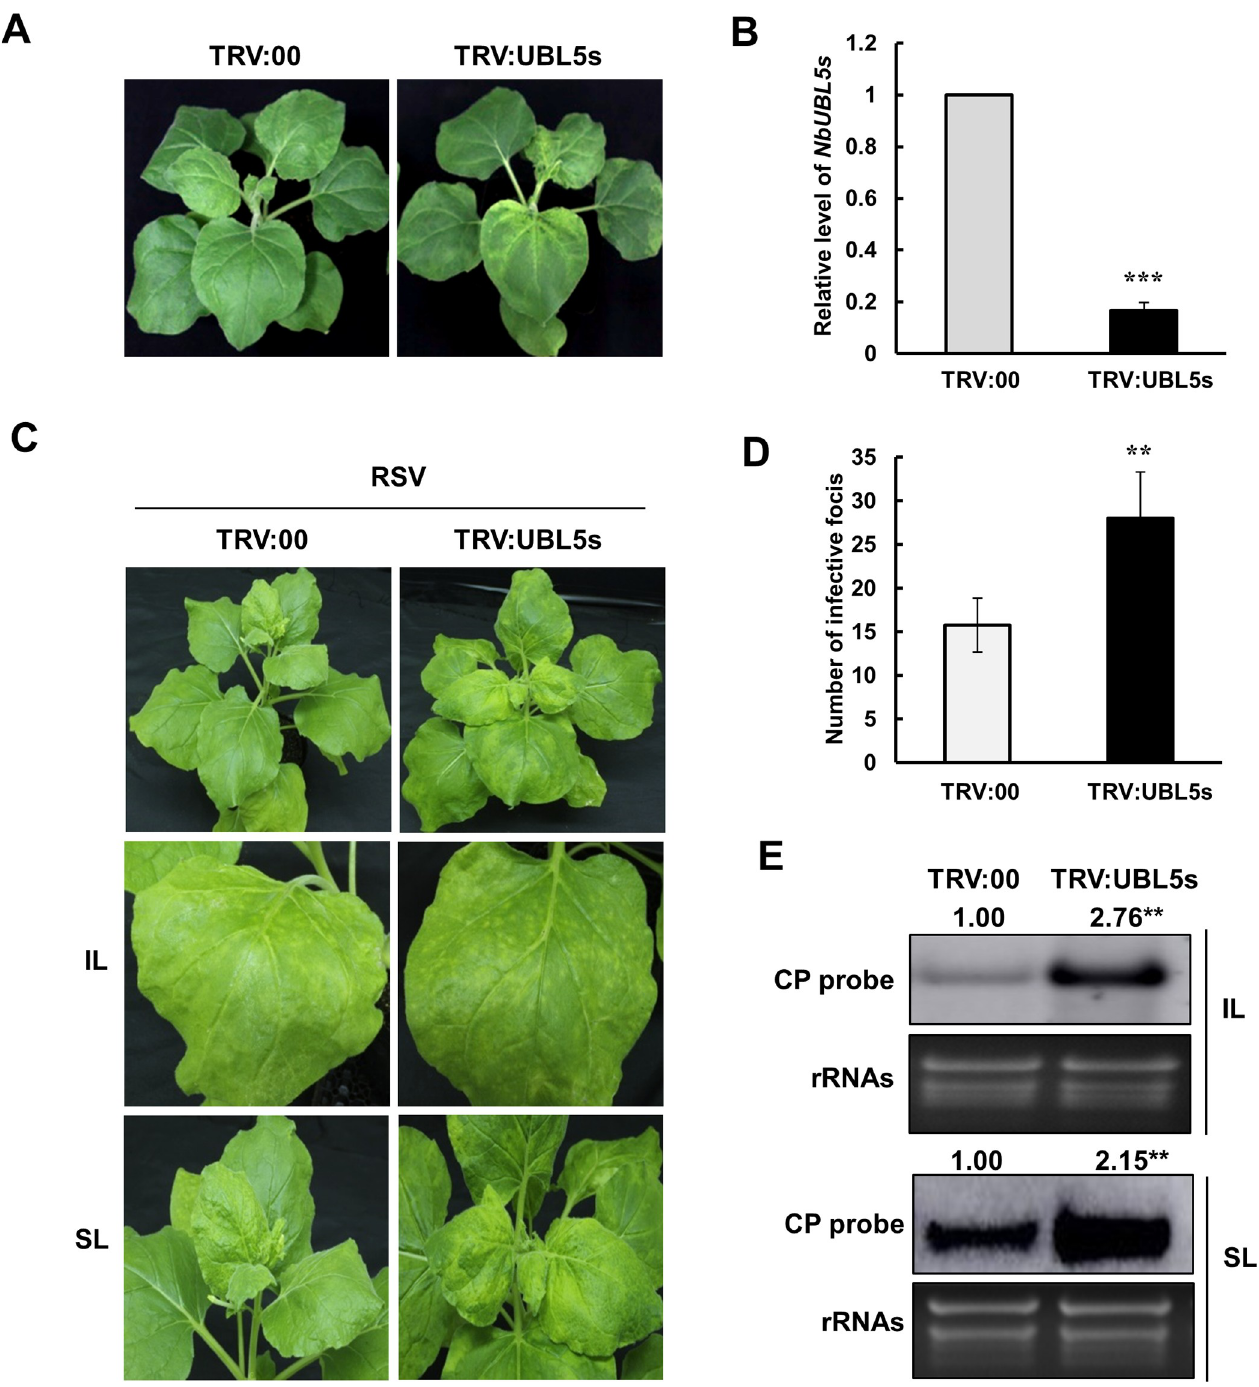
Fig 2. Silencing of NbUBL5s facilitates the infection of RSV. A. Silencing of NbUBL5s caused chlorosis on the top leaves but had no other effects on plant development. B. qRT-PCR revealed that the expression of NbUBL5s in TRV:UBL5s-infected plants was decreased to 20% of that in the control plants treated with TRV:00, indicating the silencing of NbUBL5s . C. RSV infection was monitored on NbUBL5s -silenced plants. At 7 dpi of RSV inoculation, NbUBL5s - silenced plants had more yellow infection foci and higher levels of accumulation of RSV RNAs than controls in their inoculated leaves. At 20 dpi, RSV- systemically infected leaves showed typical RSV symptoms in both TRV:00-infected and TRV:UBL5s-infected plants. D. The numbers of infection foci on the inoculated leaves of plants. E. Northern blot analysis showed that RSV RNAs in NbUBL5s -silenced leaves accumulated at higher levels than in controls. RSV CP probe was used for analysis. IL: inoculated leaves. SL: systemically infected leaves. Results are from three independent repeats. Twenty plants were used for each repeat. Bars represent the standard errors of the means from three biological repeats. Band intensity in blots was calculated by ImageJ based on three replicates. A two-sample unequal variance directional t test was used to test the significance of the difference ( �� , p value < 0.01; ��� , p value < 0.001). https://doi.org/10.1371/journal.ppat.1008780.g002 PLOS Pathogens| https://doi.org/10.1371/journal.ppat.1008780 August 31,